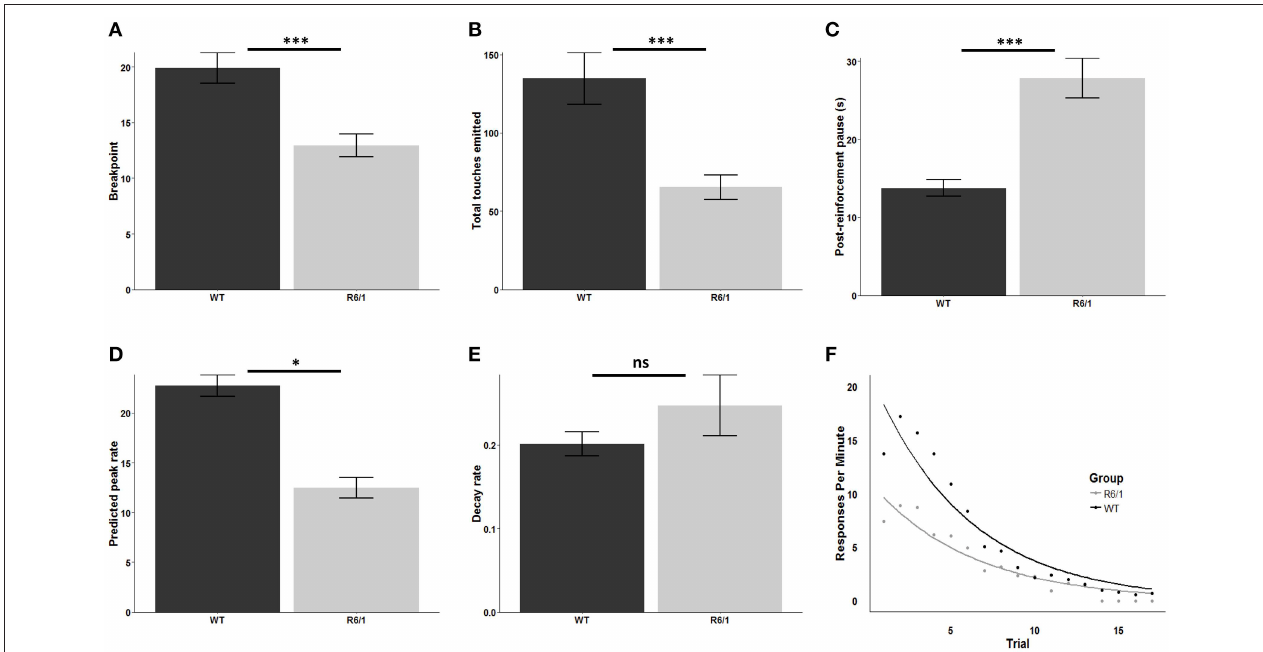
FIGURE 2 | Progressive ratio performance in R6/1 and wildtype mice. Rodent progressive ratio performance: (A) breakpoint; (B) total screen touches; (C) post-reinforcement pause; (D) predicted peak performance; and (E,F) decay rate. WT, wildtype; R6/1, HD model; * p < 0.05; *** p < 0.001; ns,